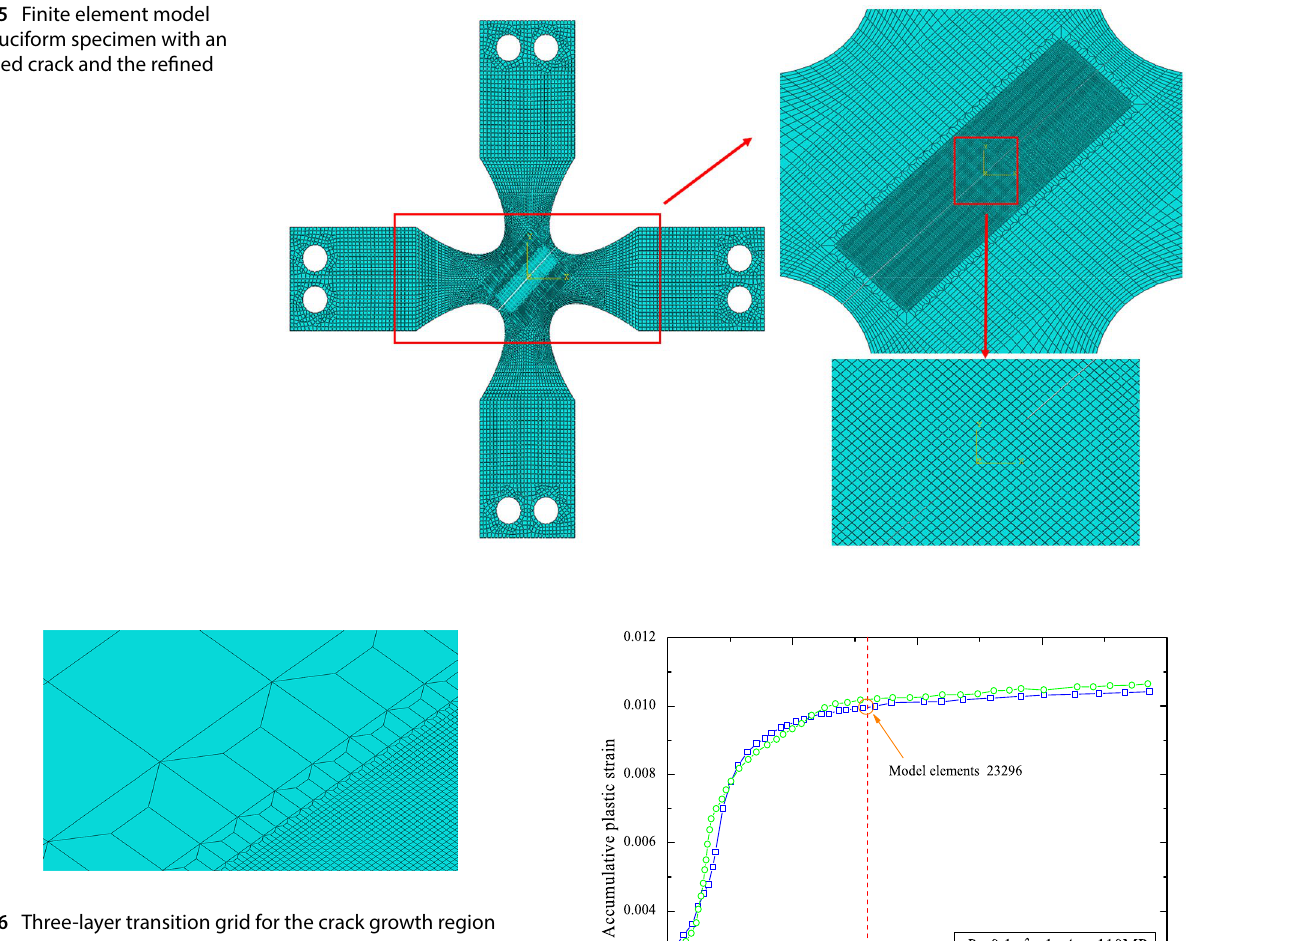
Fig. 16 Three-layer transition grid for the crack growth region